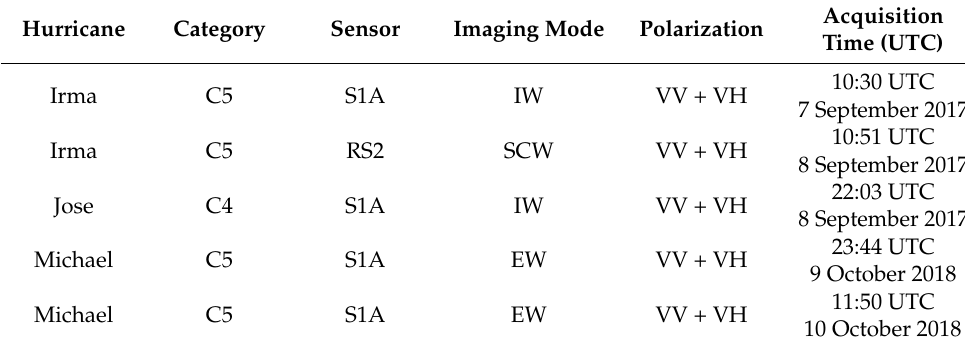
Table 2. SAR acquisitions and corresponding hurricane